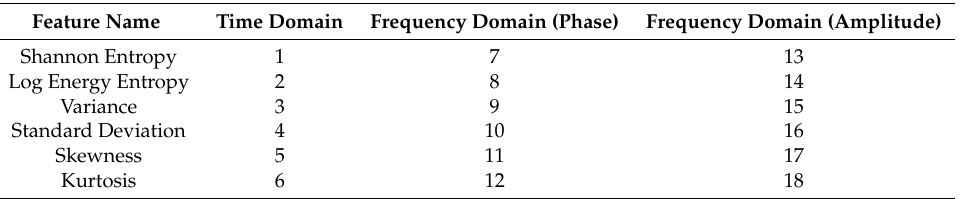
Table 2. Statistical features used for